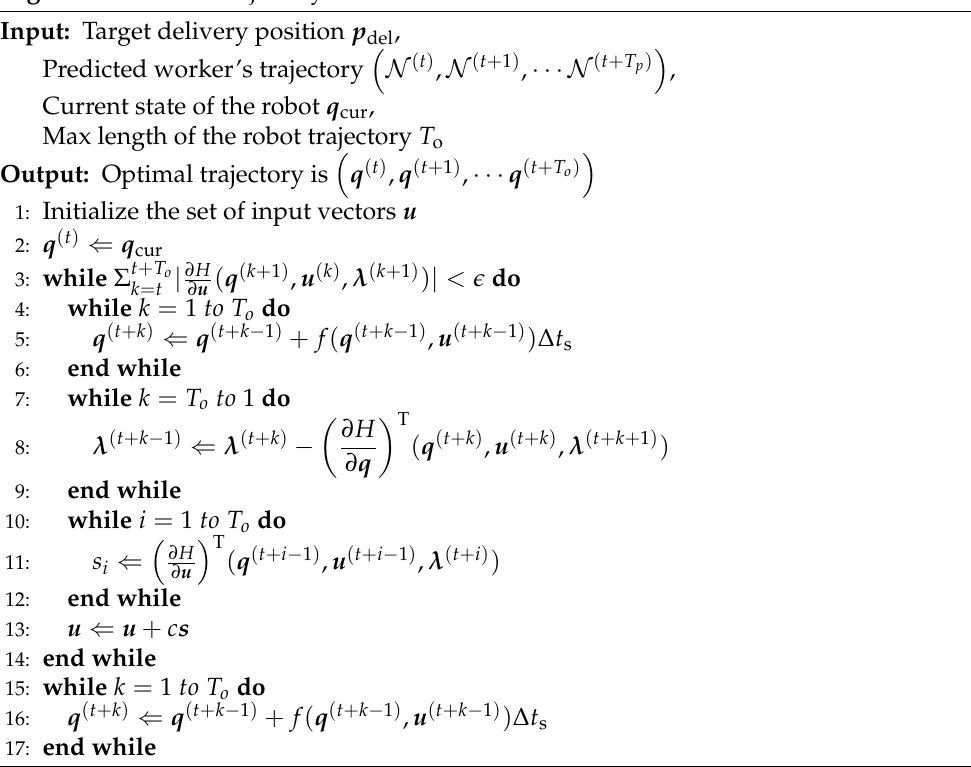
Algorithm 3 Robot Trajectory